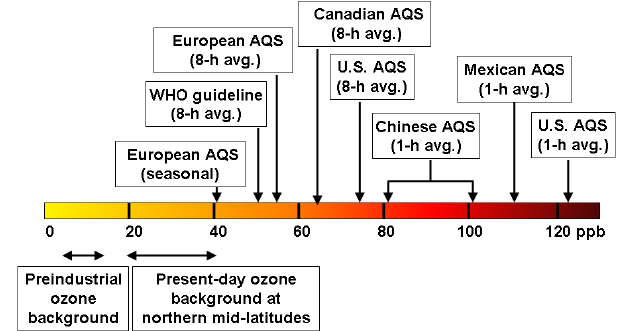
Figure 41. Ozone air quality standards (AQS) in ppb. Different na- tional and international standards are noted as well as estimates for northern mid-latitudes of the pre-industrial background (i.e. O 3 abundances with all anthropogenic emissions of NO x , CO, VOC, and CH 4 switched off, and before current climate and stratospheric O 3 change) and the present-day baseline abundances (i.e. the sta- tistically defined lowest abundances of O 3 in air flowing into the continents, typical of clean-air, remote marine sites) from Coun- cil